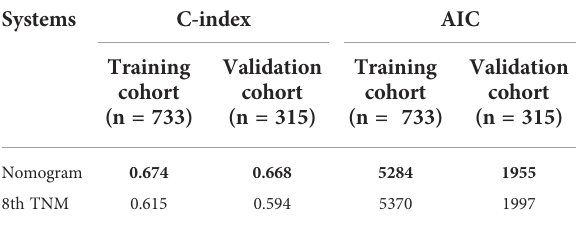
TABLE 4 Prognostic ef fi ciency of nomogram prognostic model and the 8th TNM.